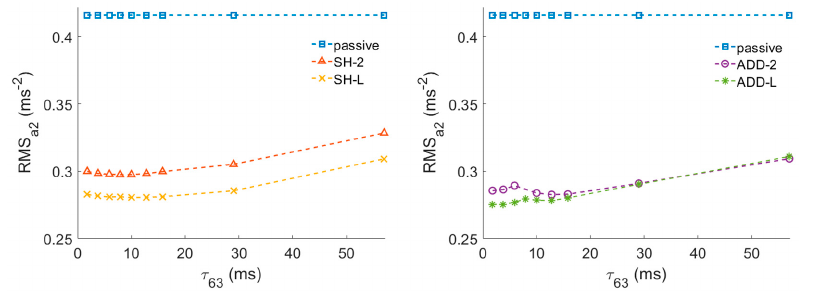
Figure 6. Damper force rise response time τ 63 effect for passive mode, SH-2 and SH-L algorithms ( left ) and passive mode, ADD-2 and ADD-L algorithms ( right ), HILS results. Table 3. Ideal response times for selected algorithm.